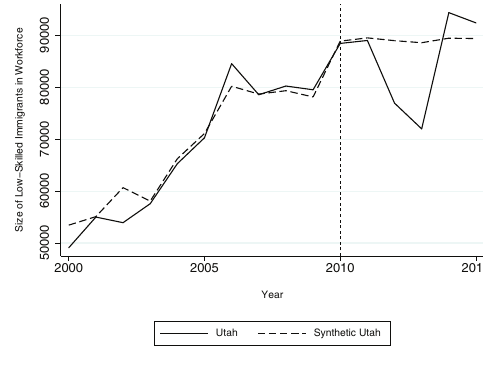
Utah universal e-verify and size of low-skilled immigrant workforce